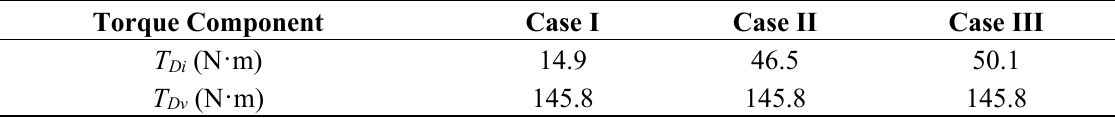
Table 3. List of the drag torque profiles under various excitation